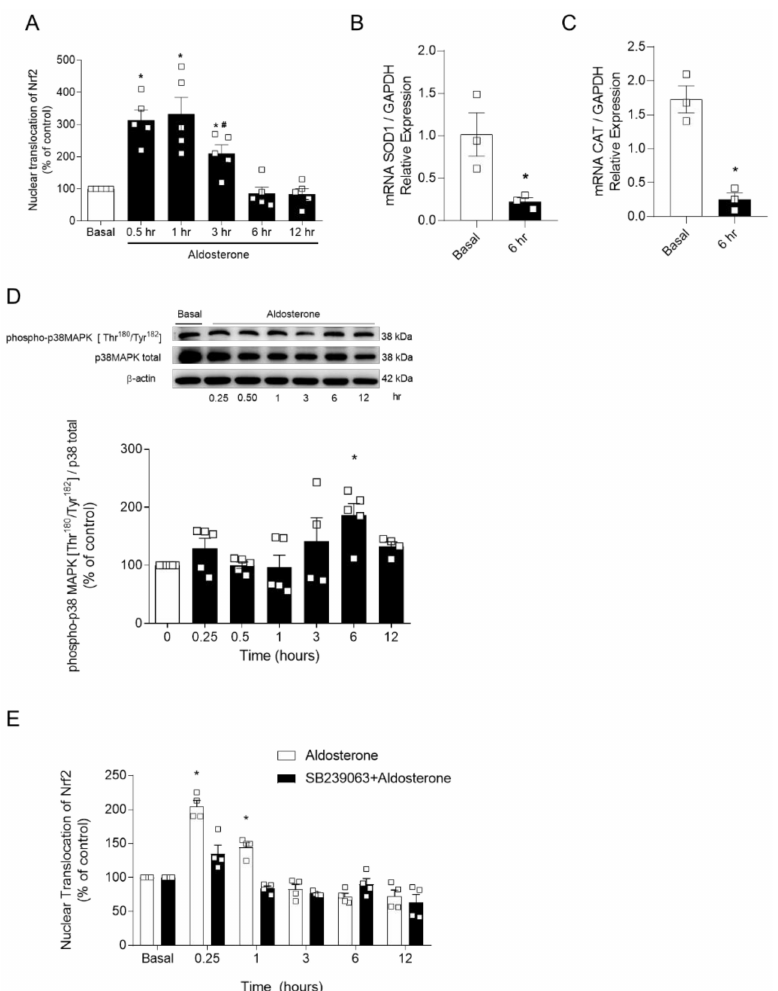
Figure 4. p38 MAPK inhibition does not prevent aldosterone-induced, reduced Nrf2 activity. Nuclear accumulation of Nrf2 ( A ) after treatment with Aldo and gene expression ( B , C ) of SOD1 and CAT. In ( D ), Aldo-induced p38 phosphorylation. ( E ), Nrf2 activity in the presence of vehicle or p38 MAPK inhibitor, SB239063 (50 µ M). Data represent the mean ± SEM. One-way ANOVA: *, p < 0.05 vs. basal; #, p < 0.05 vs. 0.5 h. n = 3–5 for each experimental